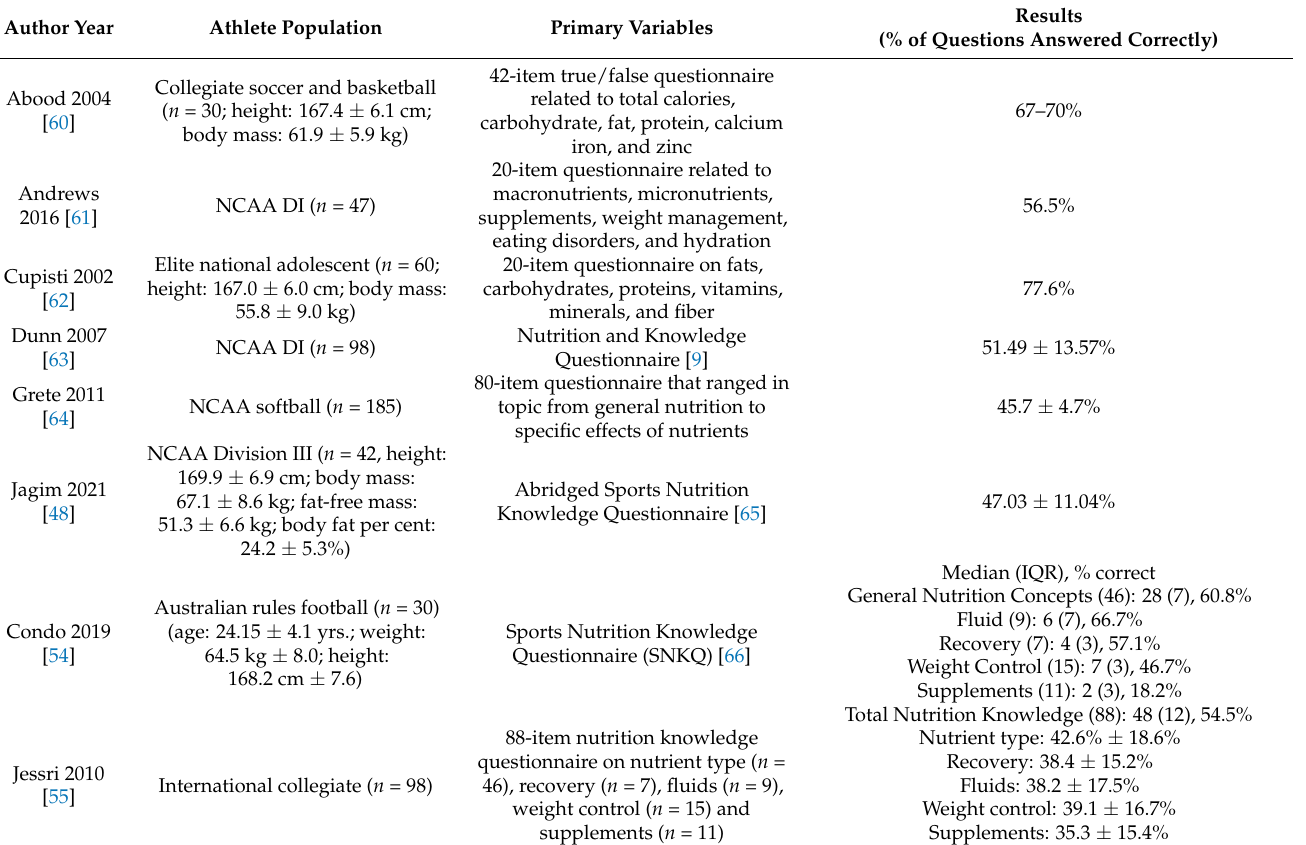
Table 2. Summary of sport nutrition knowledge of female